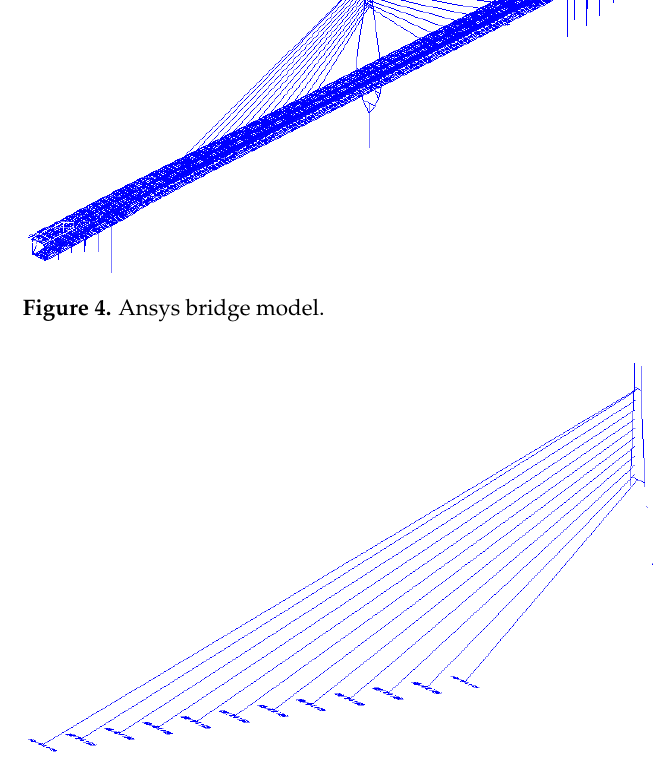
Figure 5. The cable details.